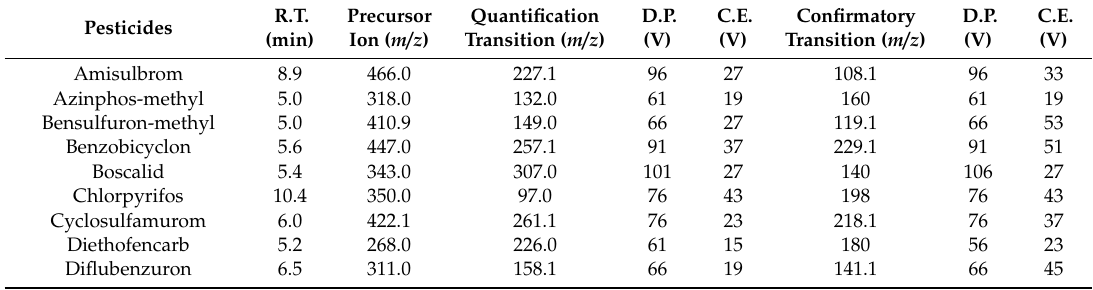
Table 1. LC-MS / MS parameter values used during the detection of 55